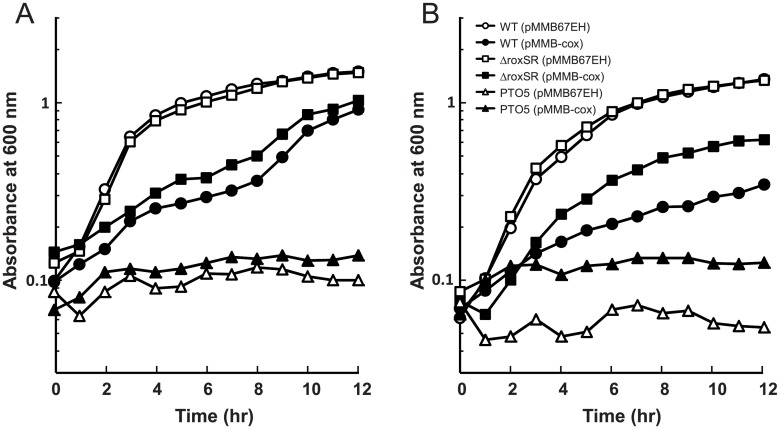
Effect of the overexpression of the cox genes.Strains transformed with pMMB67EH or pMMB-cox were cultivated aerobically in 4 ml of LB medium (A) and glutamate medium (B) in test tubes shaken at 200 rpm. The media were supplemented with 200 μg/ml carbenicillin and 0.5 mM IPTG. The results shown are representative based on at least three independent experiments. The maximum specific growth rates (μmax) of WT (pMMB67EH), WT (pMMB-cox), ROX1 (pMMB67EH), and ROX1 (pMMB-cox) were 0.79 ± 0.055, 0.30 ± 0.041, 0.72 ± 0.067, and 0.34 ± 0.103 h−1, respectively, for LB medium and 0.65 ± 0.034, 0.27 ± 0.014, 0.67 ± 0.042, and 0.50 ± 0.013 h−1, respectively, for glutamate medium. The μmax value was not calculated for the recombinant strains of PTO5, because they did not show apparent growth.